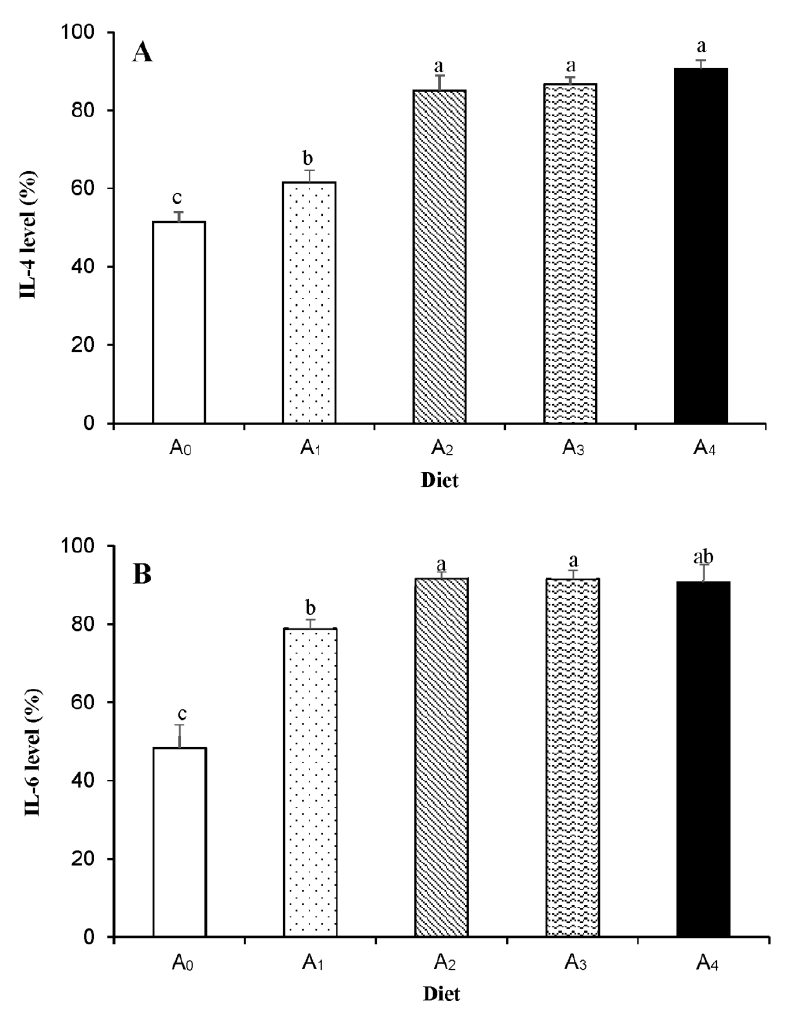
Figure 4. Expression level of hepatic IL-2 ( A ) and IL-6 ( B ) of E. coioides fed the control diet or diets containing Antrodia camphorata (AC) at 0 (A 0 ), 1.5 (A 1 ), 3.0 (A 2 ), 4.5 (A 3 ), and 6.0 (A 4 ) g kg −1 after 28 days of supplementation. IL-2, interleukin-2; IL-6, interleukin-6. See Figure 2 for statistical information.